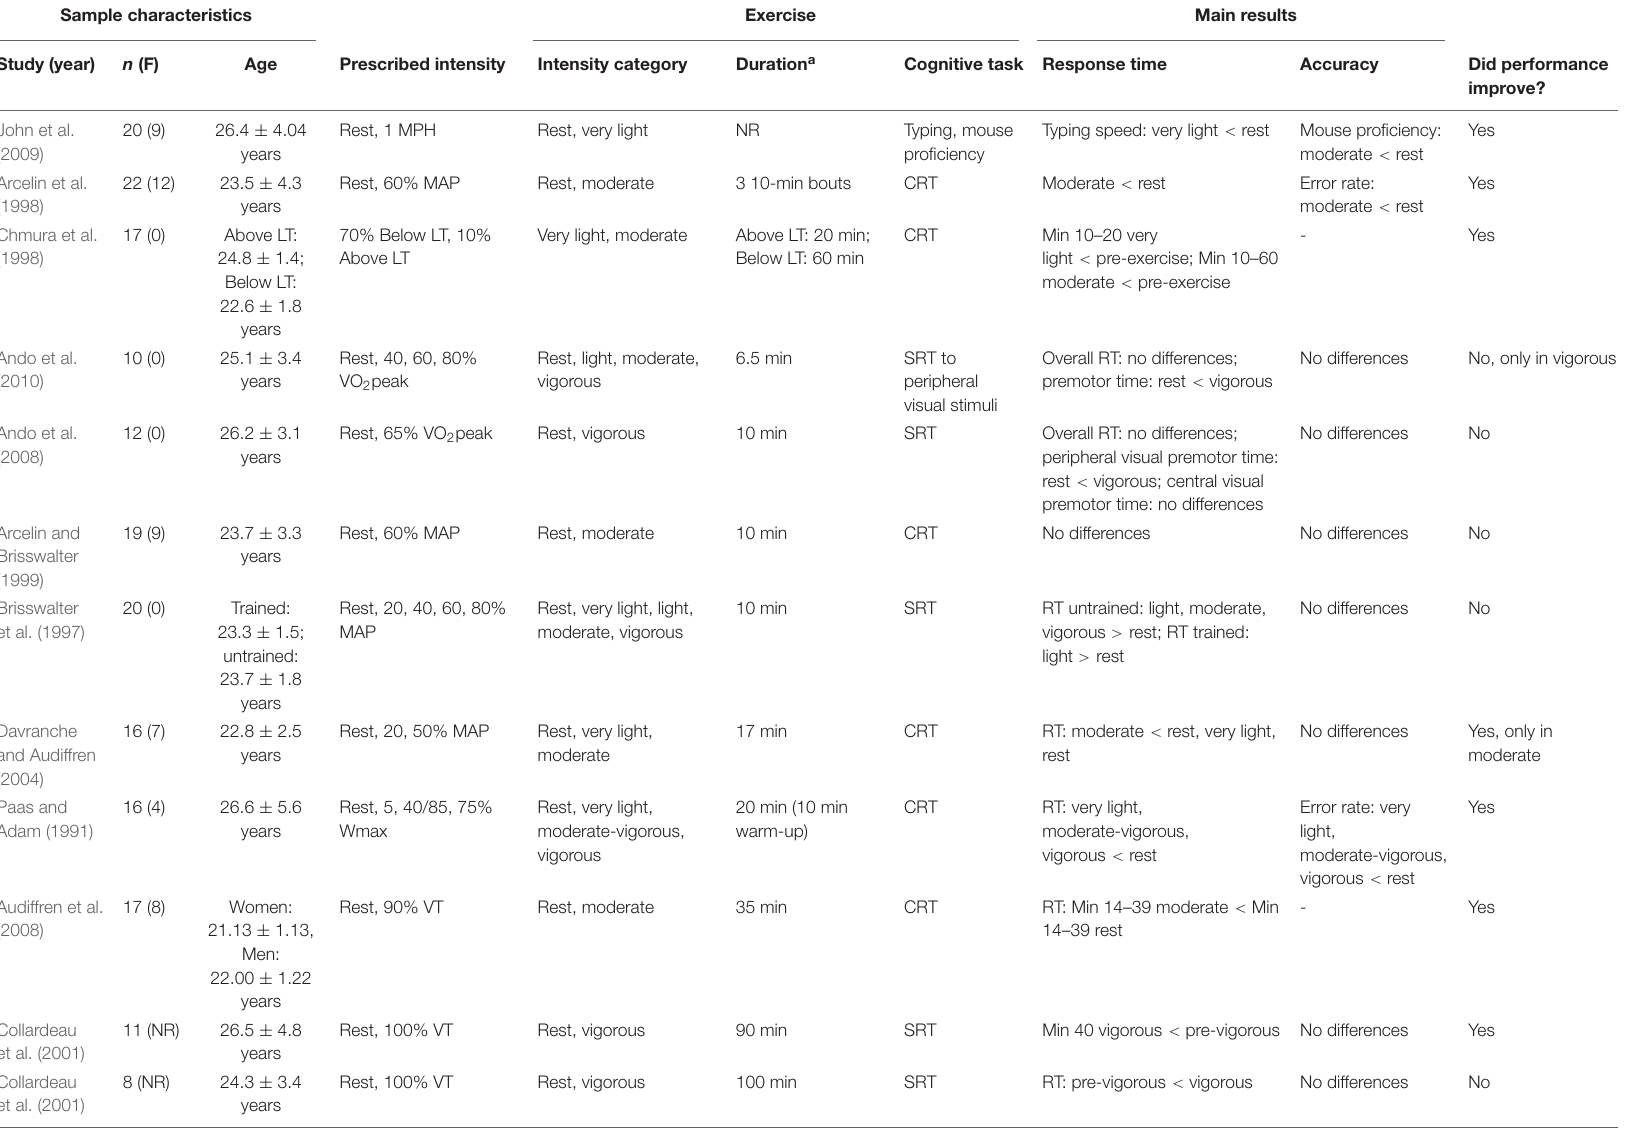
TABLE 5 | Summary of studies examining motor speed during acute aerobic